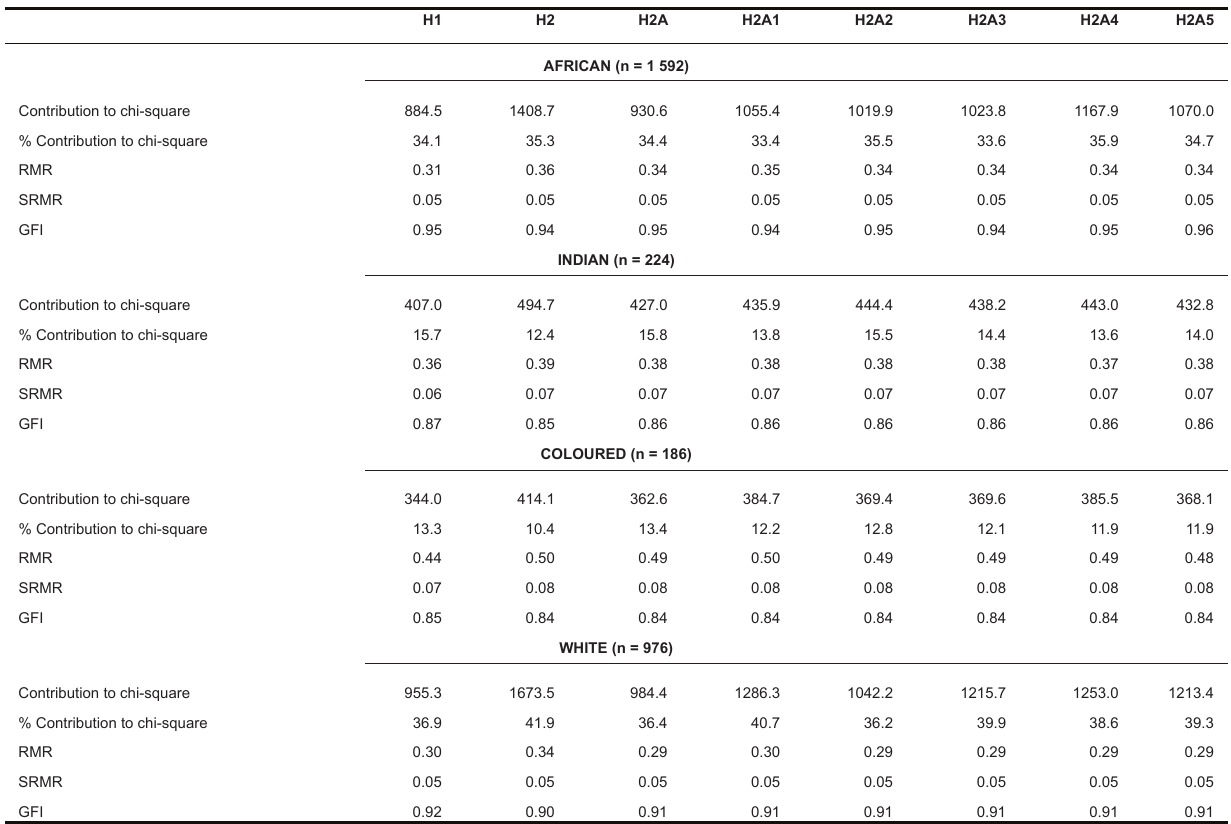
TABLE 9 Group fit indices for equivalence/invariance testing (n = 2